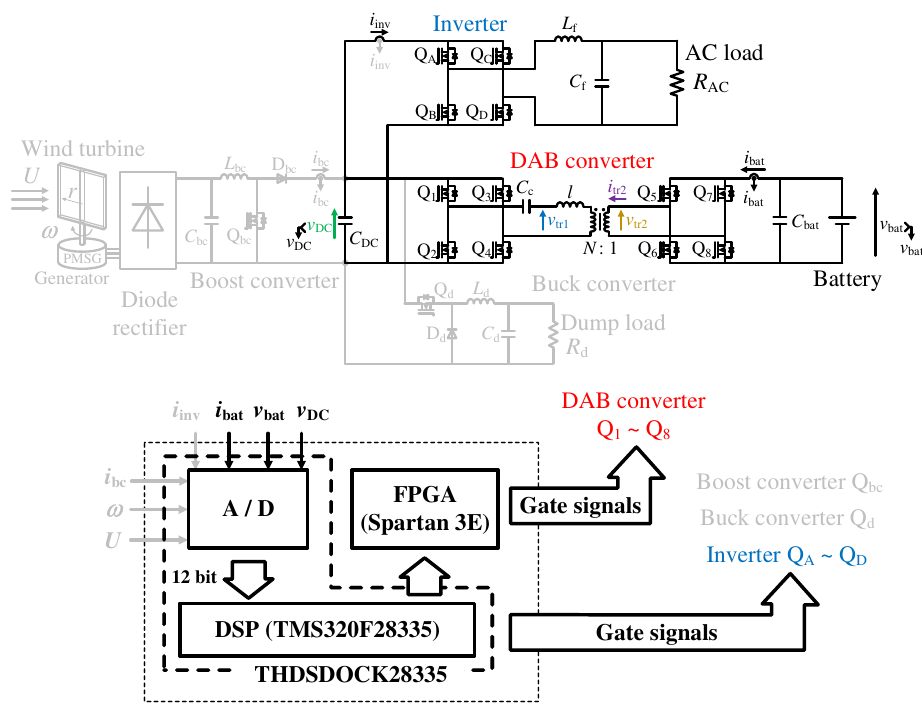
Figure 14. Block diagram of experimental setup.